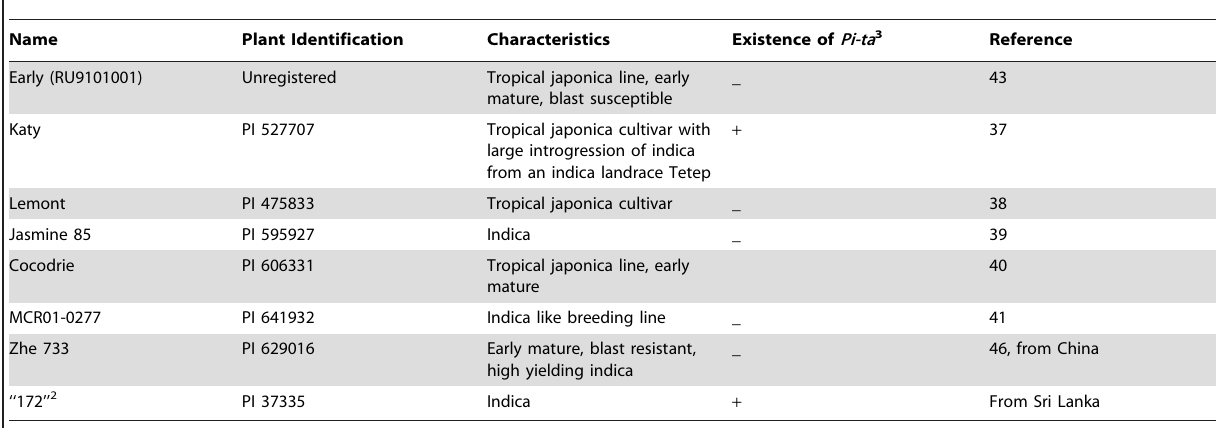
Table 2. Description of rice cultivars and breeding lines used in this study.